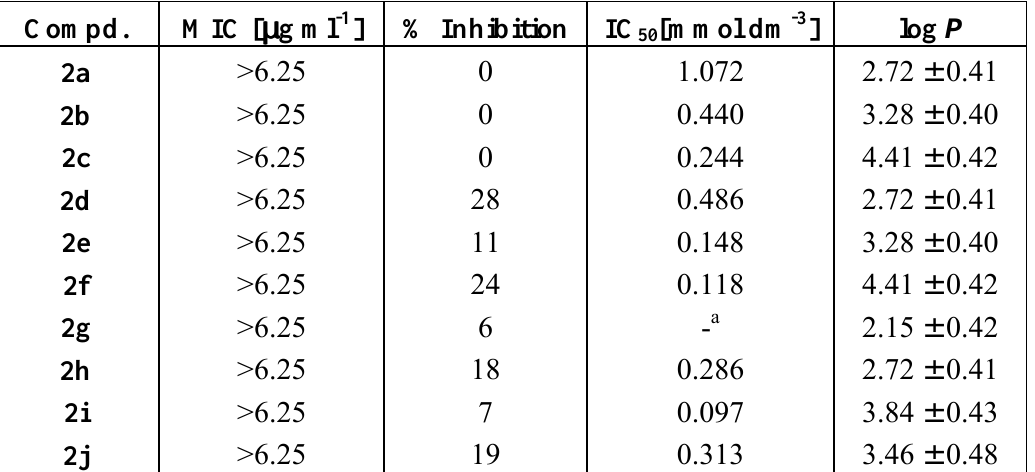
Table 1. Antimycobacterial activity (MIC, % inhibition), IC oxygen evolution rate in spinach chloroplasts by compounds 2a-r and calculated log P values of the compounds in comparison with standards rifampicine (RMP) and DCMU (see